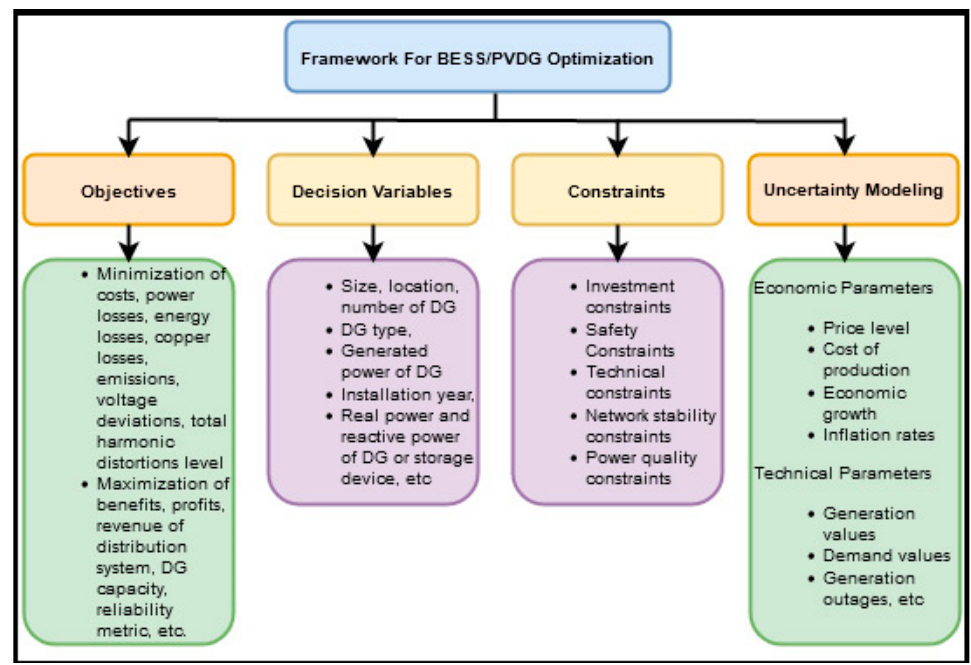
Figure 3. Framework for optimizing BESS/PVDG into distribution networks.